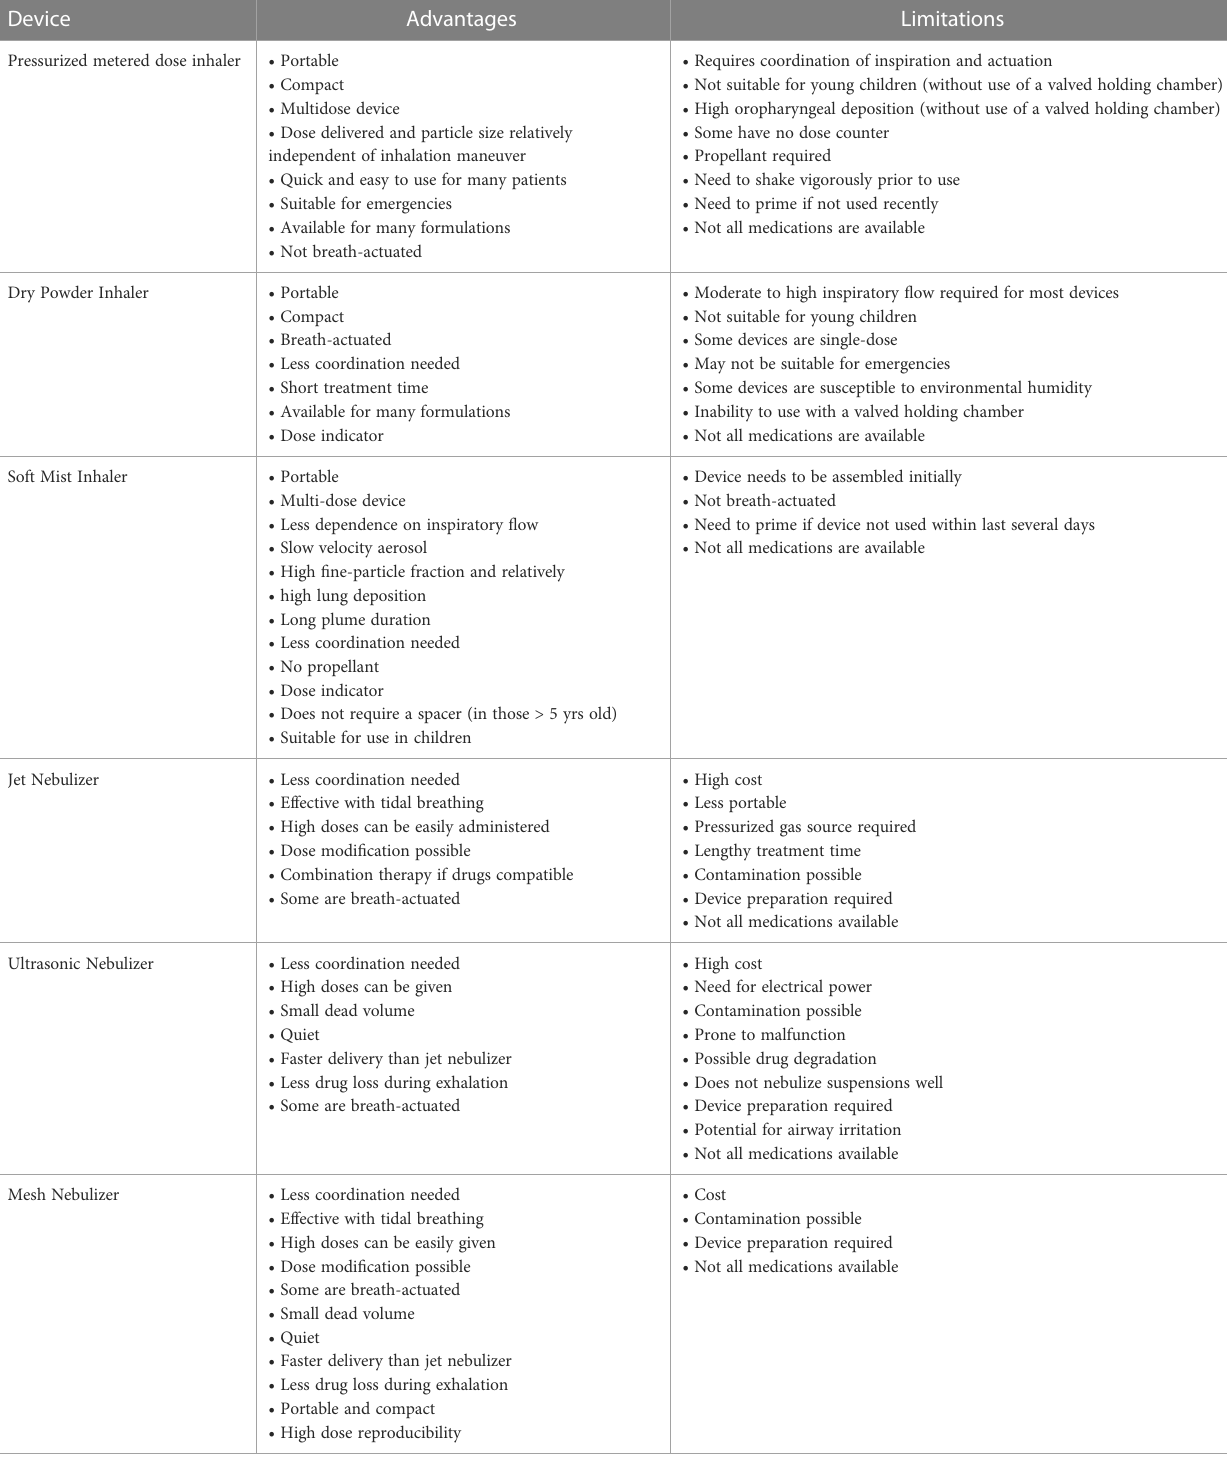
TABLE 4 Comparison of